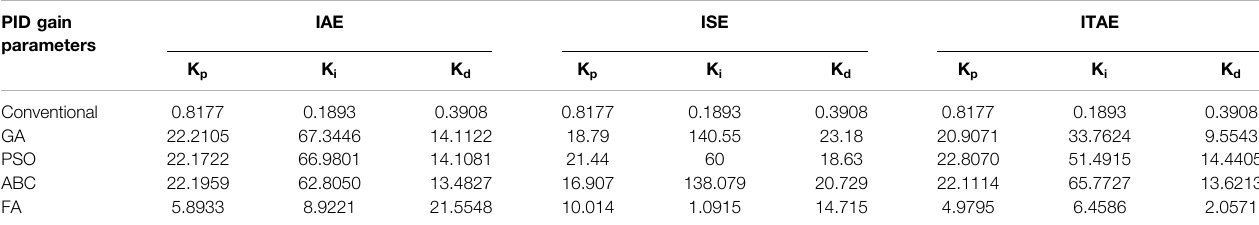
TABLE 5 | PID controller gain parameters using IAE, ISE, and ITAE objective function. PID gain parameters